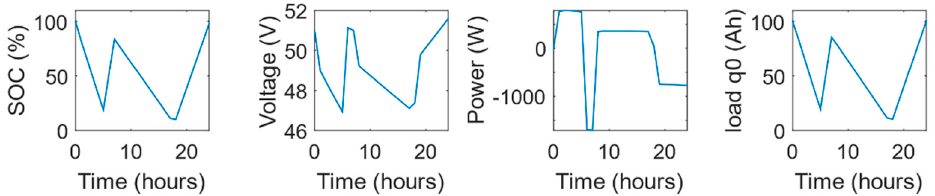
Figure 14. BESS operation schedule: ( a ) Energy distribution; ( b ) Charging and discharging currents.